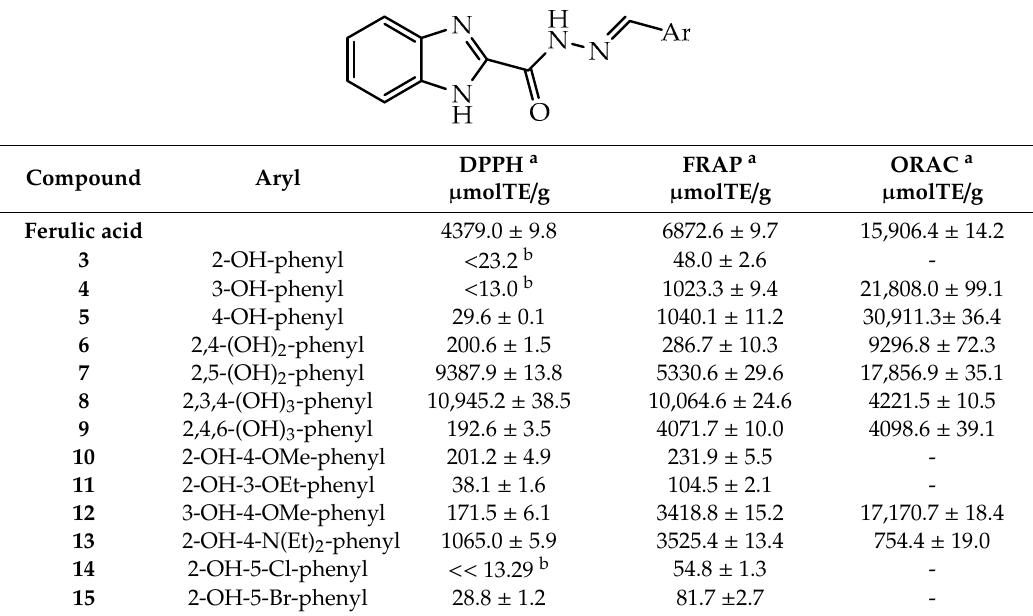
Table 1. Antioxidant activity of N 1 -(4-arylidene)-1 H -benzo[ d ]imidazole-2-carbohydrazides 3–15.